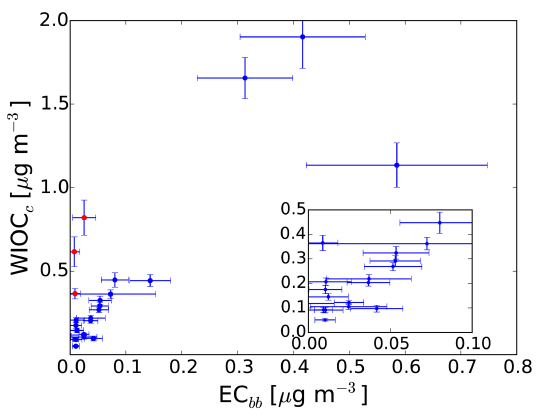
Figure 8. Scatter plot of contemporary water-insoluble carbon con- centrations (WIOC c ) against EC derived from biomass burning (EC bb ) . EC bb has been corrected for the contribution of highly re- fractory primary OC during three pollen events (red points).